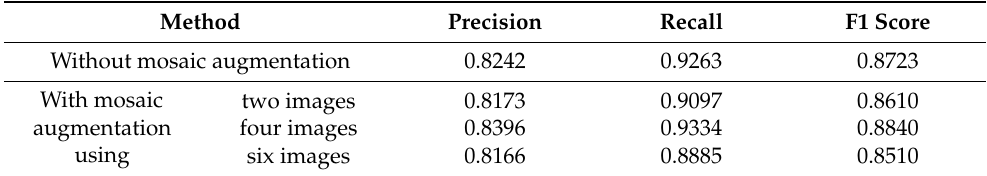
Table 6. Performance comparisons with or without mosaic augmentation, and with mosaic augmen- tation according to the various number of